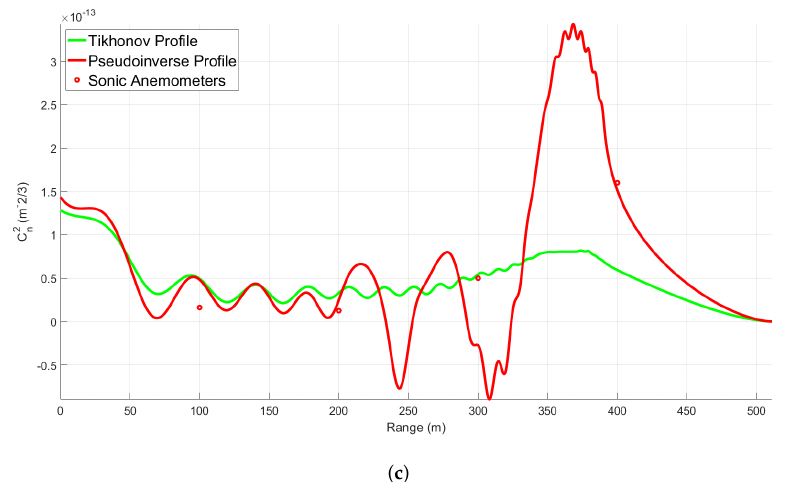
Figure 8. Example of how a turbulence profile calculated by Tikhonov regularization is affected by ridge parameter selection. ( a ) Under regularized profile with α = 15; ( b ) Optimally regularized profile with α = 30; ( c ) Over regularized profile with α = 60.